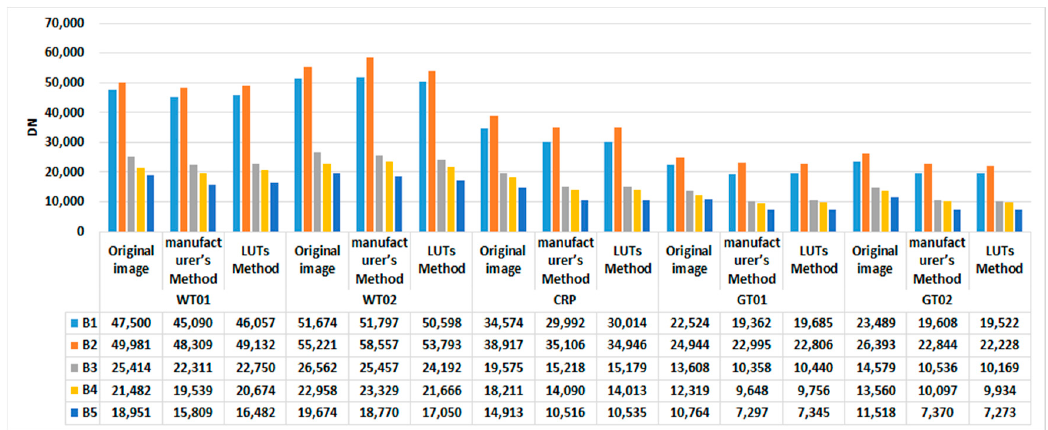
Figure 20. Mean digital number (DN) of five targets in the original image and the images corrected by the two calibration methods.